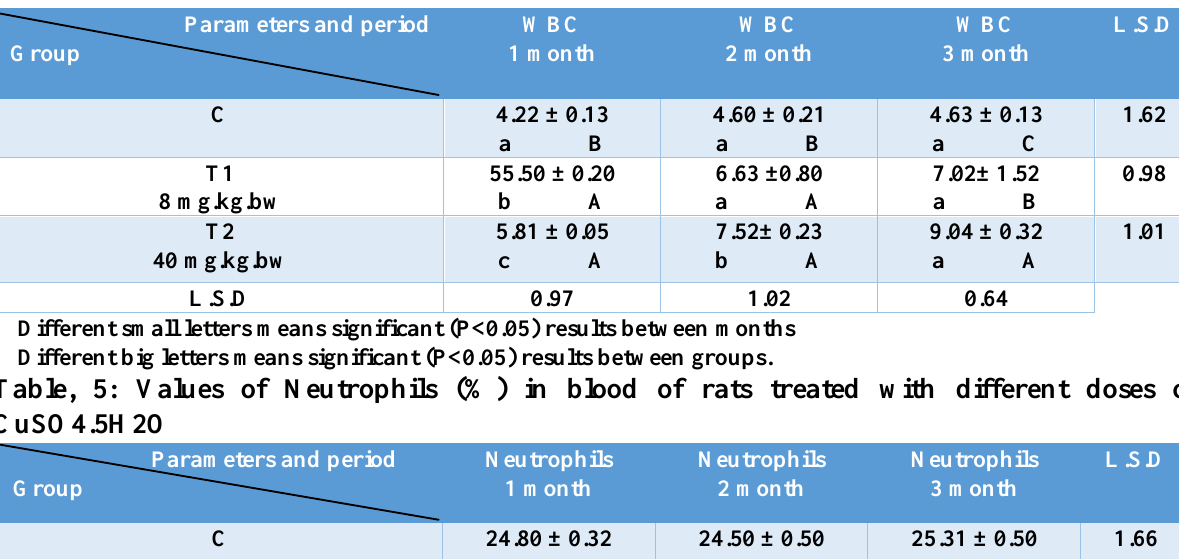
Table, 4: Values of WBCs (cells*50 /cm³) in blood of rats treated with different doses of CuSO4. 5H2O